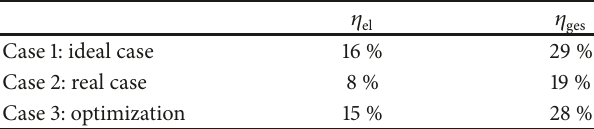
Table 6: Comparison of